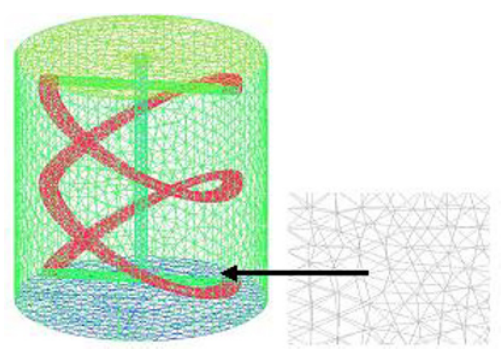
Figure 2. Numerical grid (tetrahedral mesh).